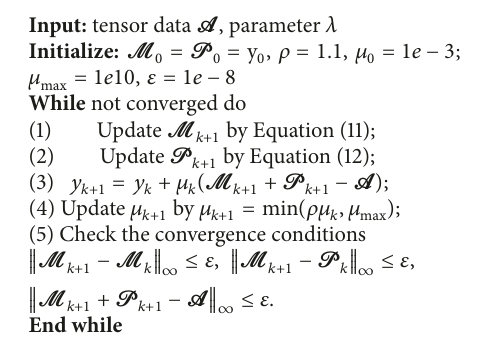
Algorithm 1: Algorithm 1 solves (9) by